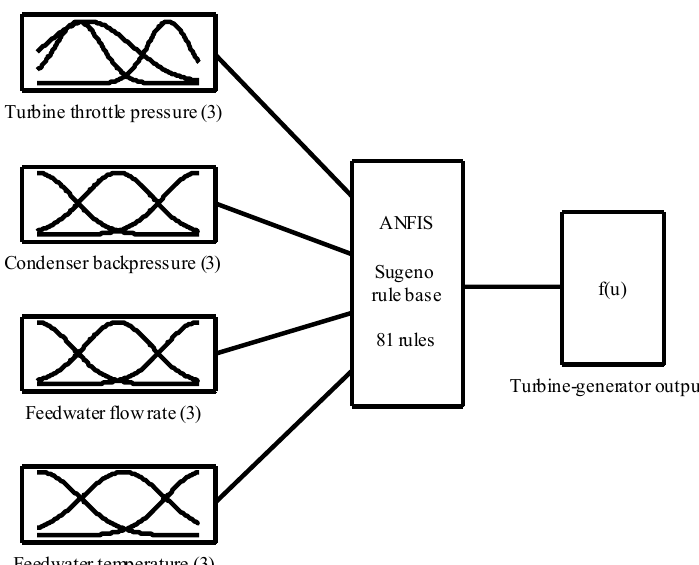
Figure 9. Structure of the ANFIS based turbine cycle model for the Kuosheng